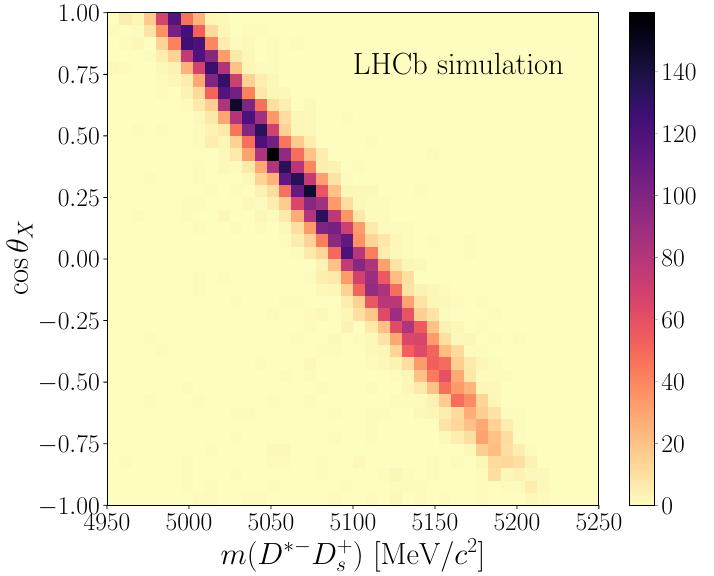
) and cos θ in a sample of fully reconstructed X s